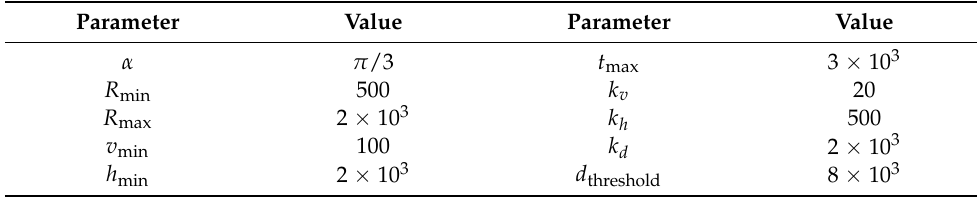
Table 3. Relevant parameters of air